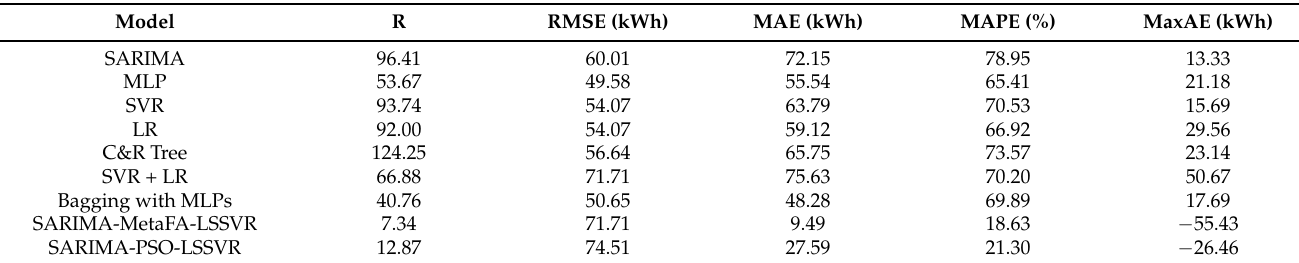
Table 4. The percentage difference (%) between the proposed hybrid system (EvoHyS) and literature models according to Equations (15) and (16).